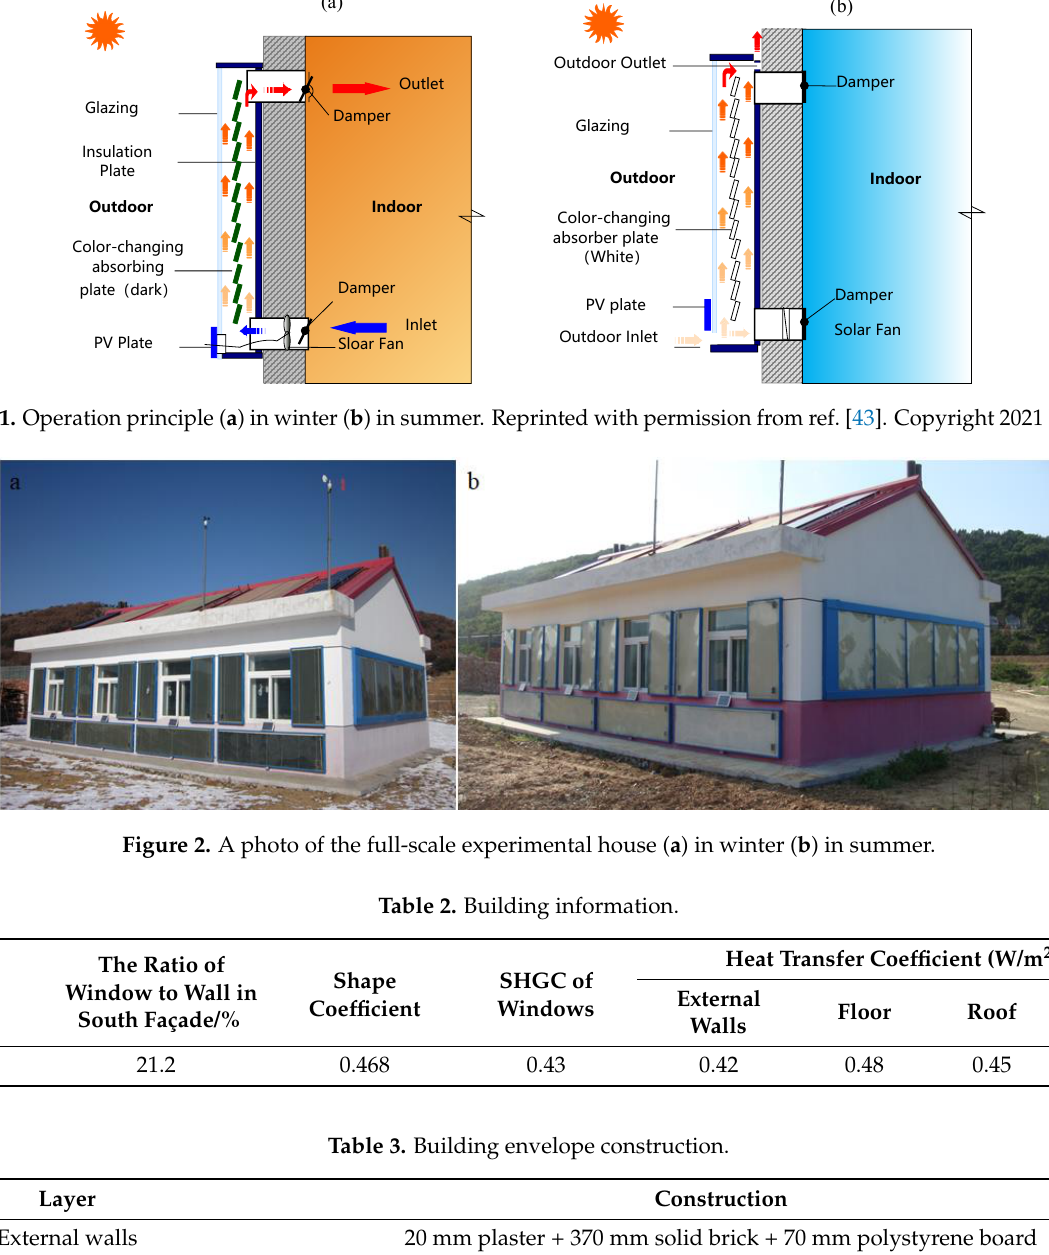
Figure 1. Operation principle ( a ) in winter ( b ) in summer. Reprinted with permission from ref.